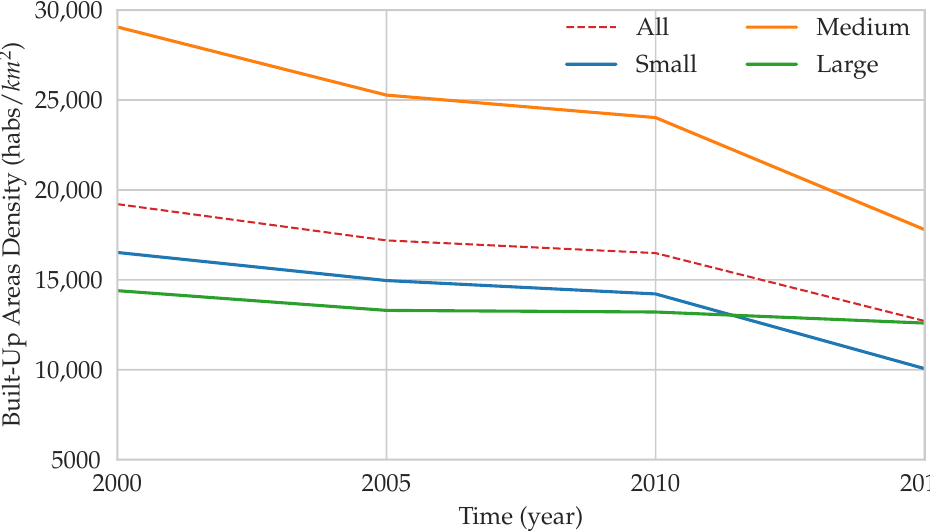
Figure 10. Evolution of population densities in built-up areas (people per km 2 ) between 2000 and 2015 for small (less than 500,000 people in 2000), medium (between 500,000 and 1,000,000 people), and large cities (more than 1,000,000